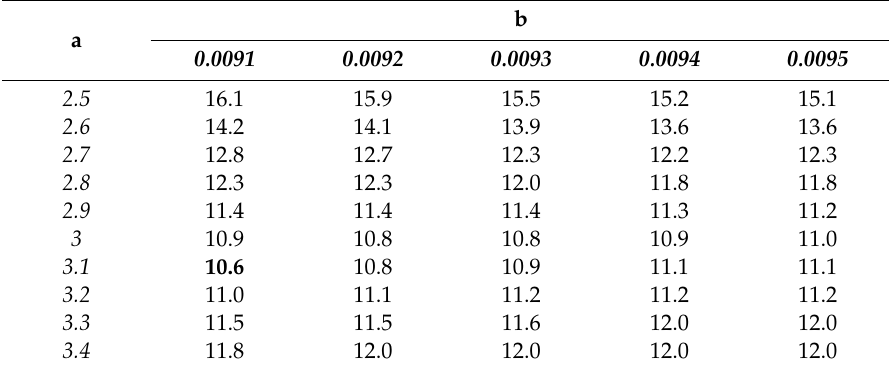
Table A2. RMSE of the number of trees measured in the field against the number of trees from the model. The table shows the RMSE for the quadratic function y = a + b ∗ Height 2 . The rows indicate the parameter a and the columns parameter b. The RMSE is the most optimal with the function Crown area = 3.1 + 0.0091 ∗ Height 2 .